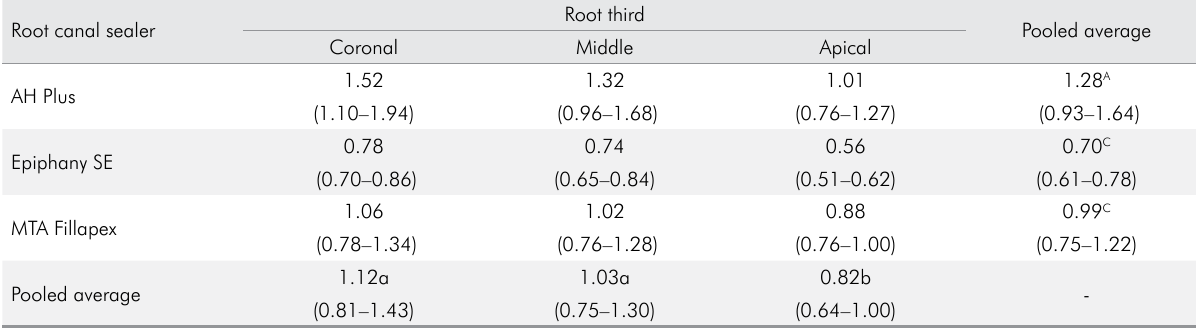
Table 3. Results for root canal sealers and root thirds (Means, 95%CI) in MPa.